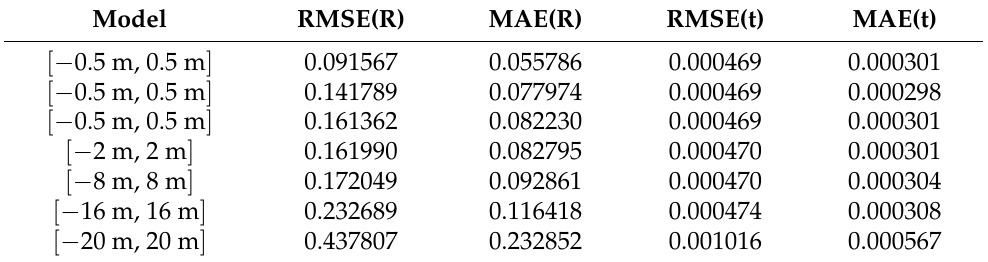
Table 6. Test results on TUM3D.